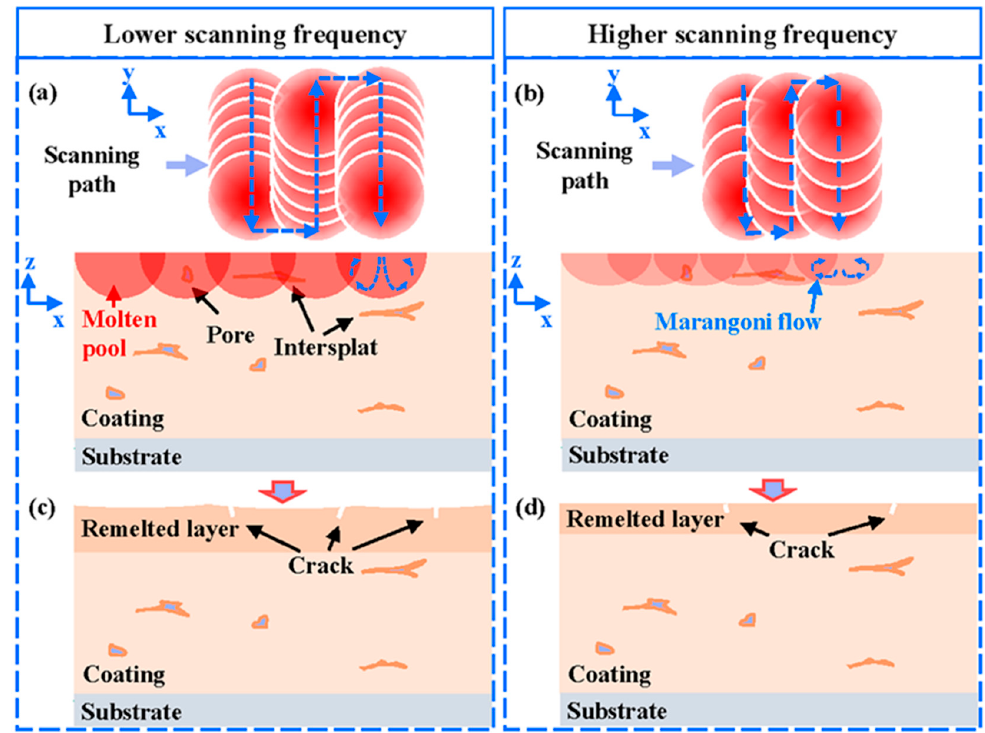
Figure 12. Schematic diagram of nanosecond pulsed laser progressing: ( a ) the distribution of pulsed laser spots on the coating surface at lower pulse frequencies; ( b ) the distribution of pulsed laser spots on the coating surface at higher pulse frequencies; ( c ) the remelted layer cooled at lower frequencies; and ( d ) the remelted layer cooled at higher frequencies.